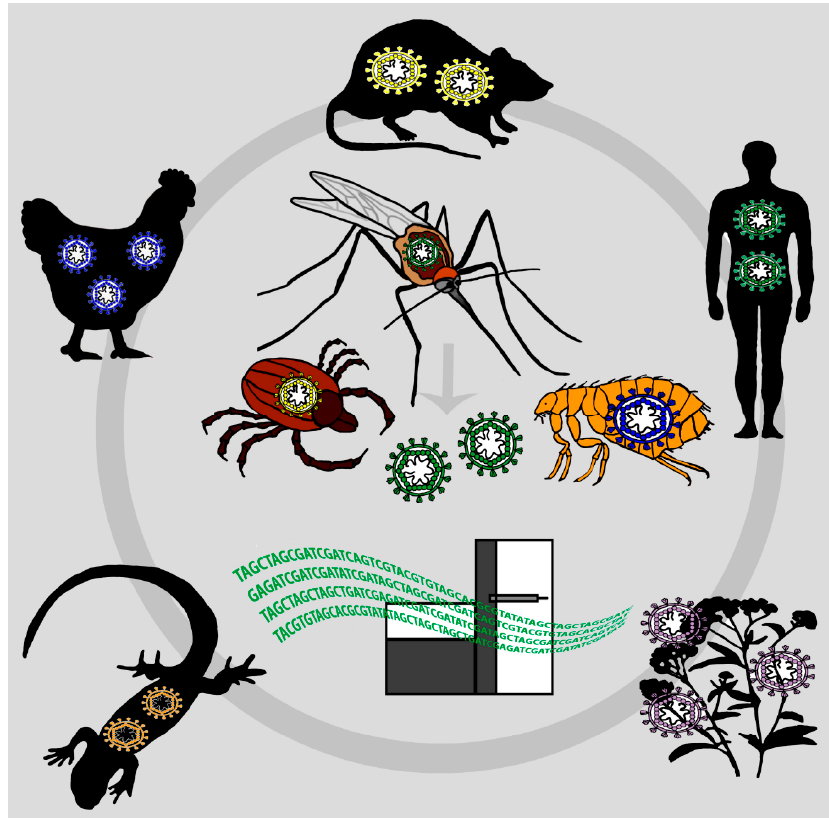
Figure 1. Vector-enabled metagenomics (VEM) as a tool for virus surveillance: Hematophagous arthropods feed on a wide range of hosts. The blood meals of mosquitoes, ticks, fleas, flies and midges therefore reflect the viral diversity of the host on which the arthropod has fed on, including mammals, birds, reptiles, humans and plants. Sequencing of such arthropods’ blood meals with next-generation sequencing technologies can shed light on the viral diversity of several host species within a distinct region and can be used as a tool for viral disease